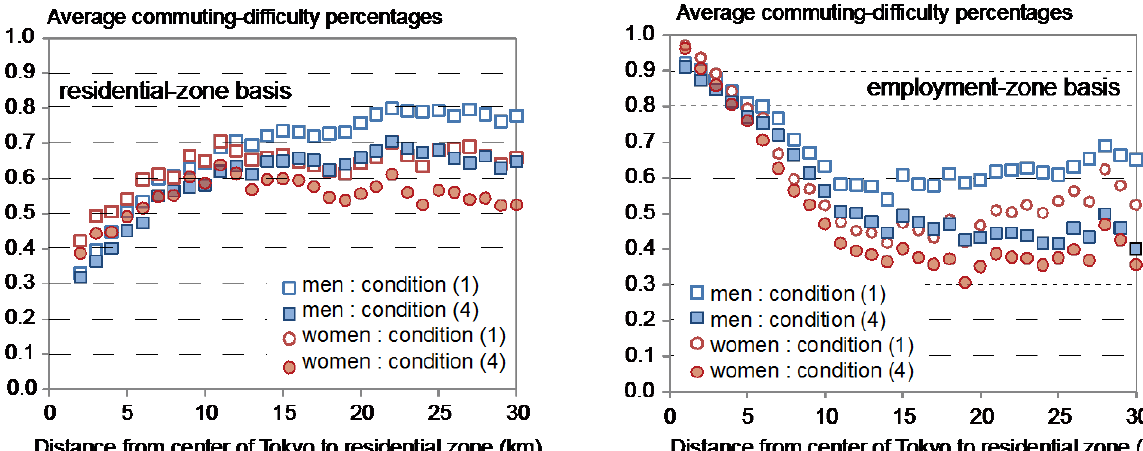
Figure 15. Average percentages of commuting difficulty for men versus women according to distance from the urban center of